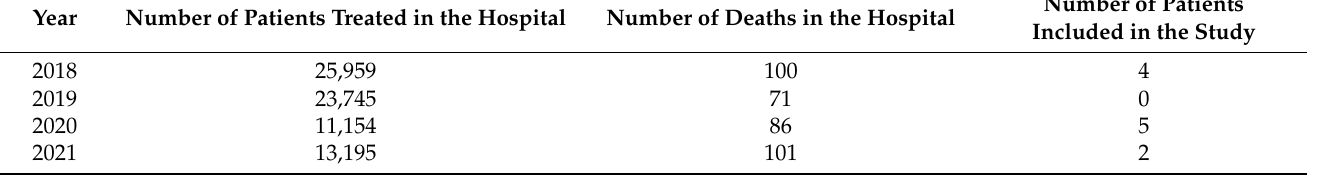
Table 2. Magnitude of the